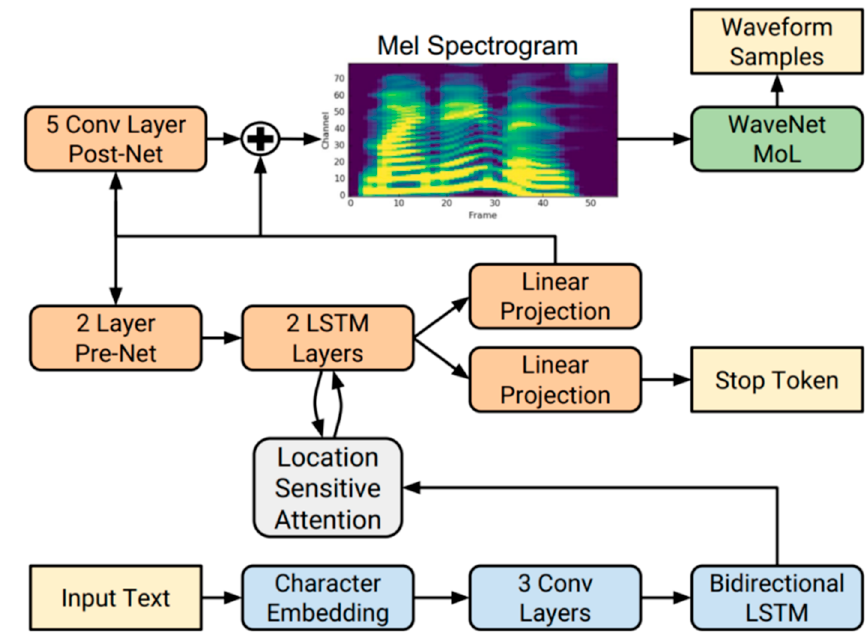
Figure 2. Block diagram of the Tacotron 2 system architecture [27].